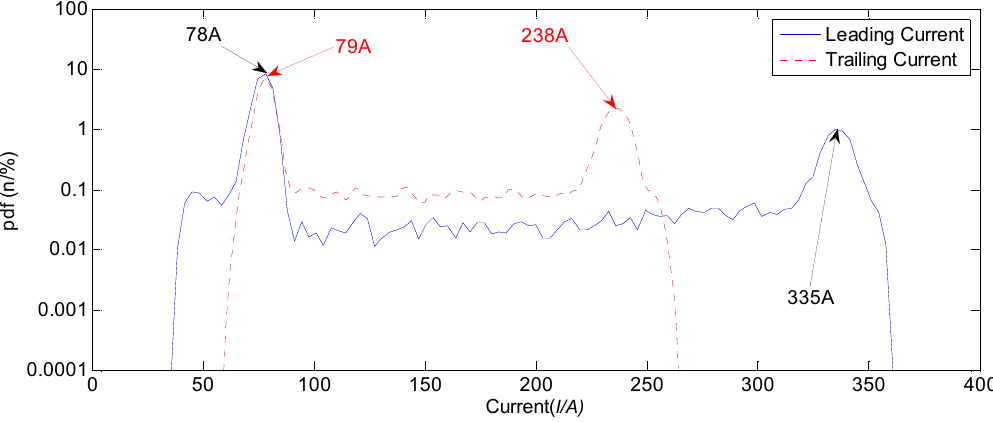
Figure 12. Current waveform under the optimized parameters.